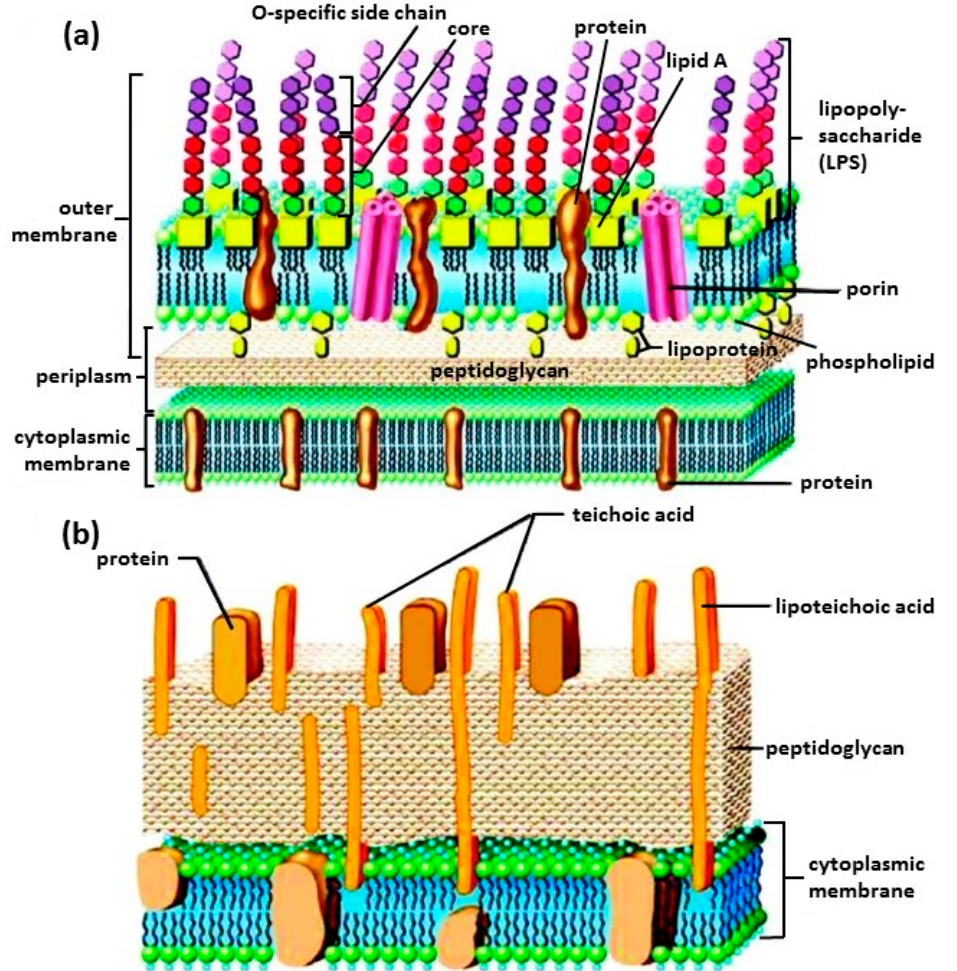
Figure 1. A cartoon view of the membranes of: ( a ) Gram-negative bacterium; and ( b ) Gram-positive bacterium. The membranes of Gram-negative bacteria are composed of two layers: the outer membrane rich in lipopolysaccharide (LPS) and the inner membrane rich in anionic phosphatidylglycerols (PG). Gram-positive bacteria have a cell wall consisting of lipoteichoic acid and peptidoglycan and a cytoplasmic membrane. Reproduced with permission from Elsevier [4]. Some bacteria may have a capsule that is more external than the cell envelope. This capsule is not shown in Figure 1. Bacterial capsules are composed of high-molecular-weight polysaccharides and/or polypeptides, and are associated with virulence and biofilm formation [10]. The capsule